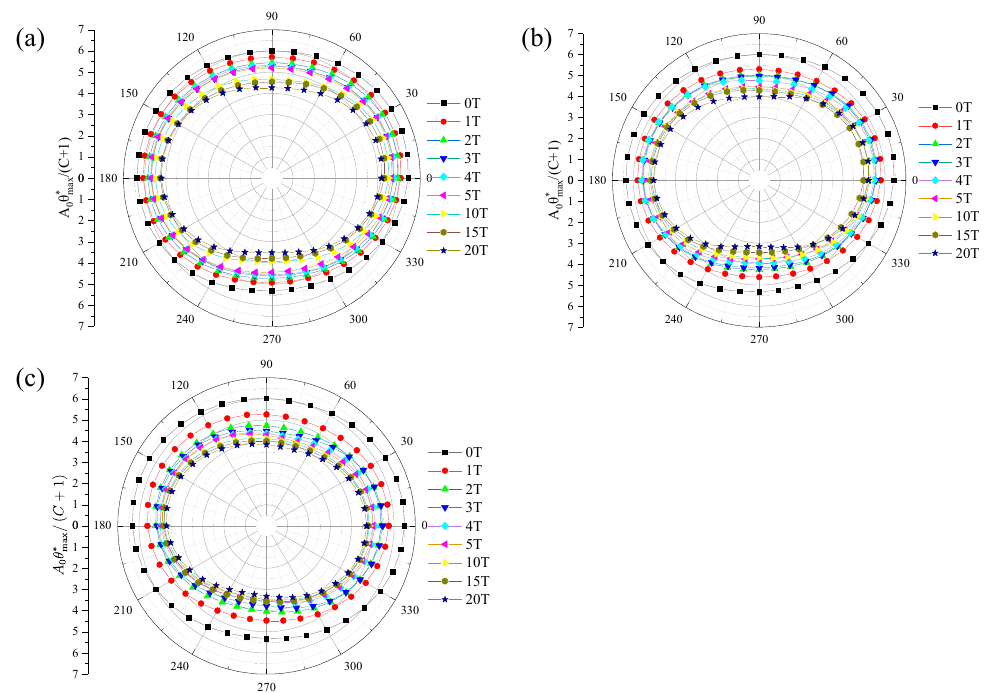
Figure 9. Polar plots of the 3D roughness parameter, A 0 θ ∗ max / ( C + 1 ) , of the lower joint surface under different normal stresses: ( a ) 0.4 MPa, ( b ) 1.0 MPa, and ( c ) 2.5 Mpa.